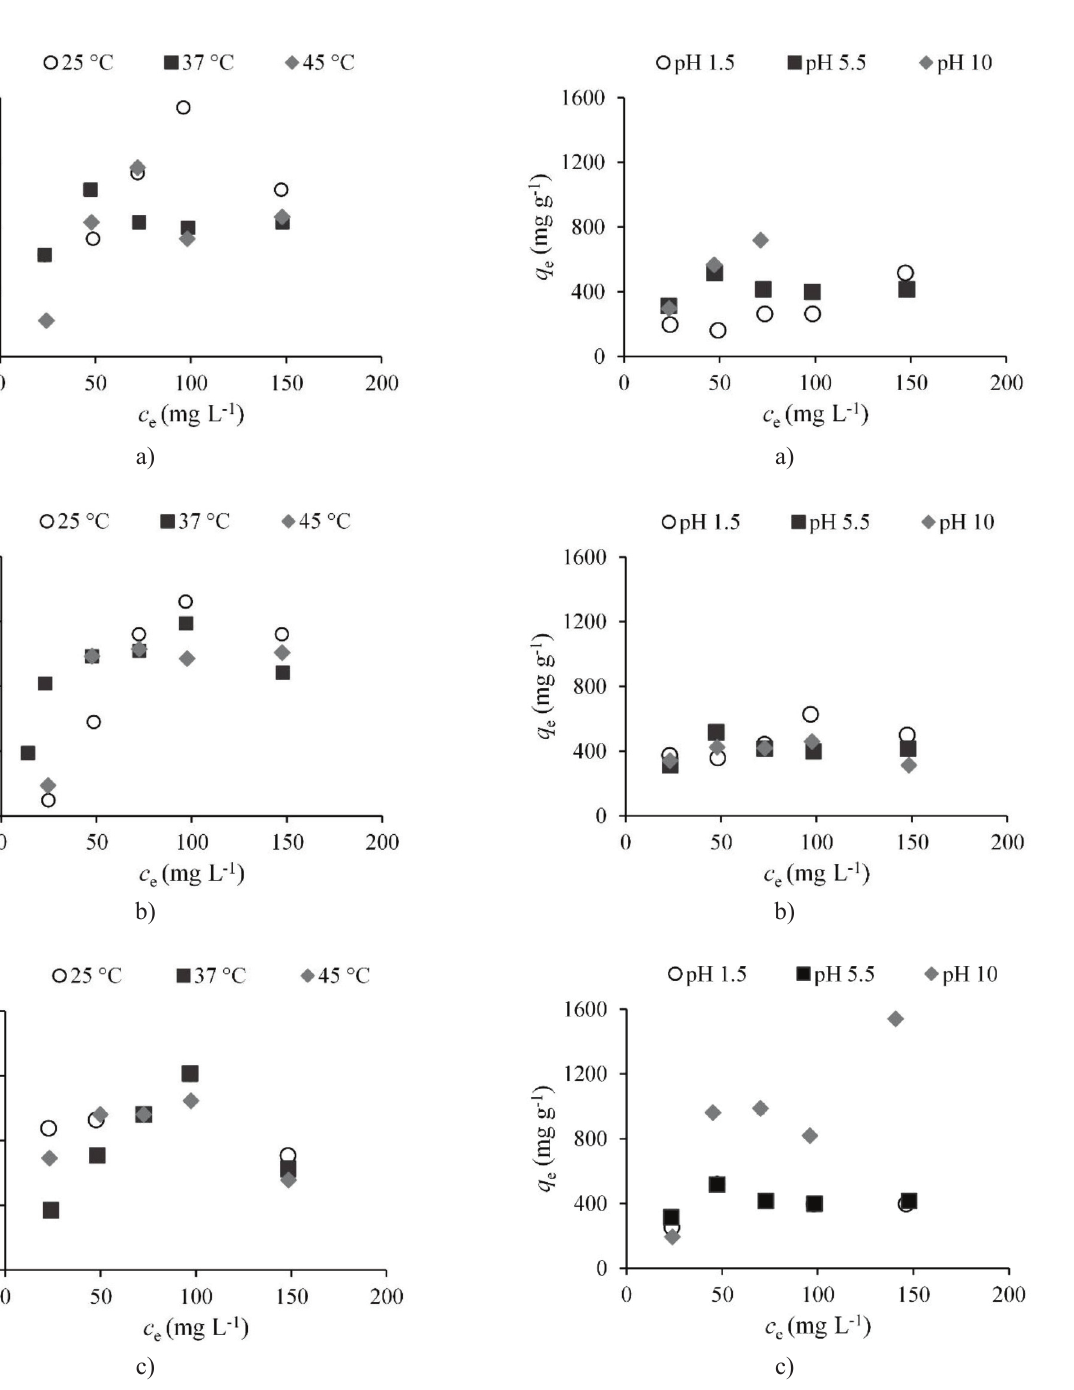
vs c diagrams) at e e